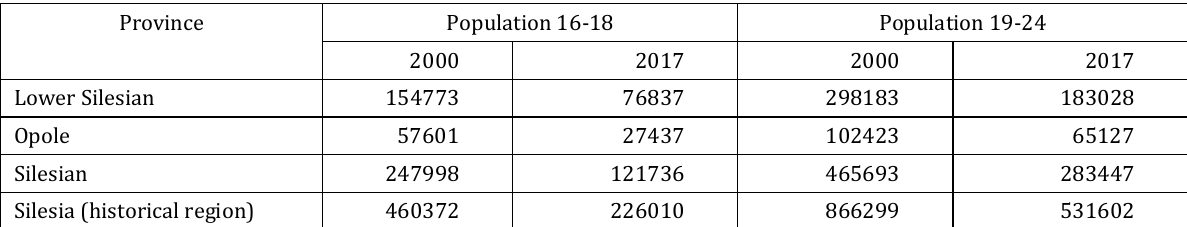
Table 3. Number of students within historical Silesia by selected group (Source: authors own on the basis of Higher